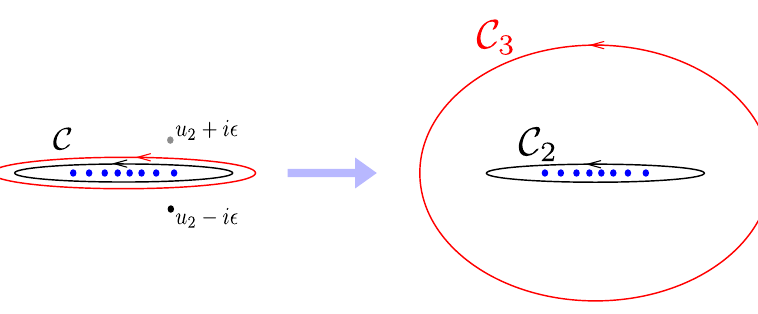
Figure 6. The deformation of the contours and the Clustering mechanism. To evaluate Z anti ( z ) in the large N limit, we first deform the original contours C so that each contour is far apart from each other ( C 1 ≺ C 2 ≺ C 3 ). Upon doing so, the contour picks up contributions from poles at u j = u k − i(cid:15) . Such contributions are important to obtain the correct large N